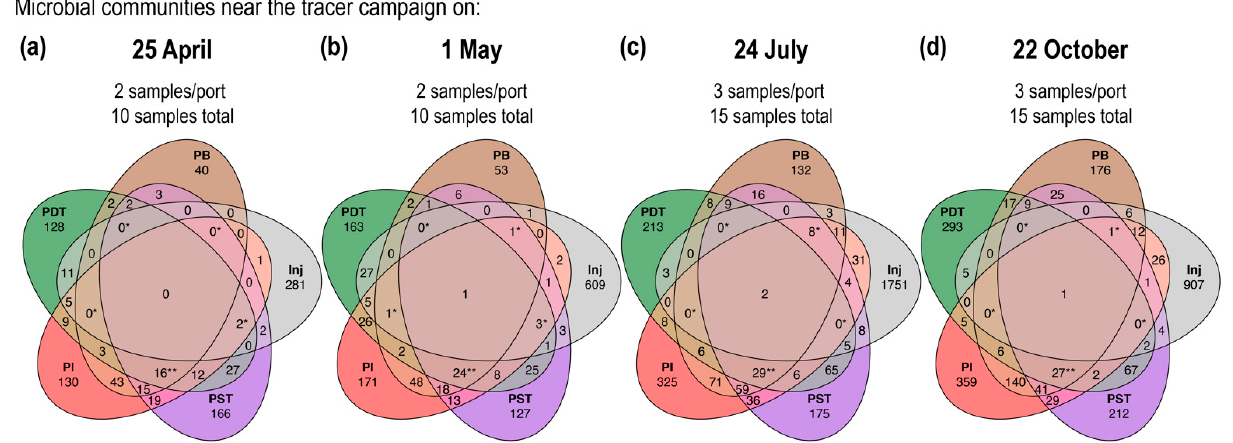
Figure 5. Venn diagrams evaluating the number of shared ASVs among different wells near the tracer campaign on ( a ) 25 April, ( b ) 1 May, ( c ) 24 July, and ( d ) 22 October. The number of ASVs shared among all four producing wells are indicated by two asterisks; the number of ASVs shared among any other four wells are indicated by one asterisk. The sum of all the numbers in each ellipse represents the total number of unique ASVs detected in this well near (as defined in Table A1) this tracer campaign.